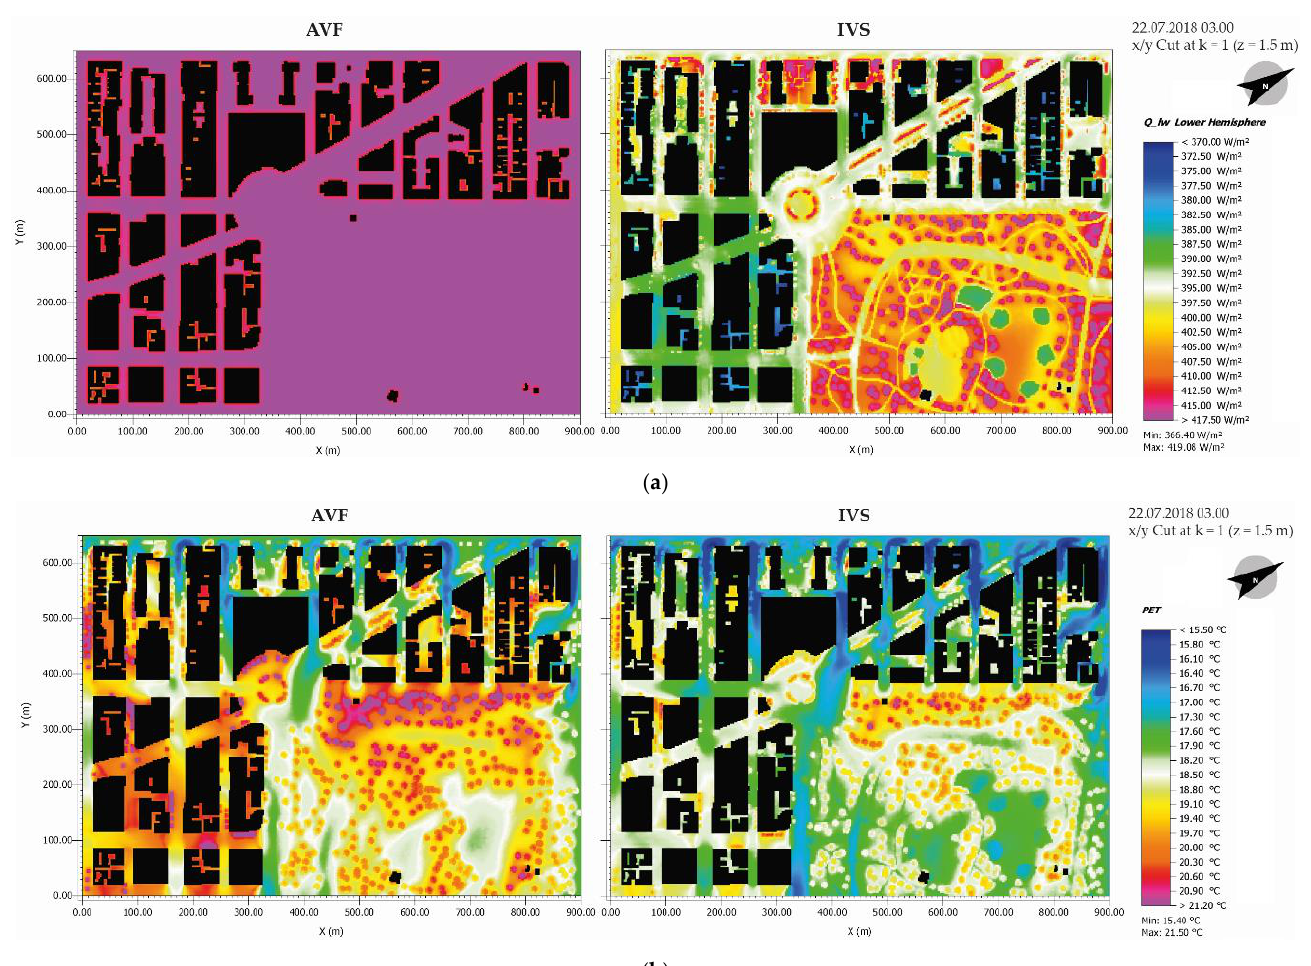
Figure 9. Comparison of proof-of-concept simulation results between AVF and IVS at 03.00 in a height of 1.5 m for longwave radiation received from the lower hemisphere ( a ) and for PET ( b ), respectively.